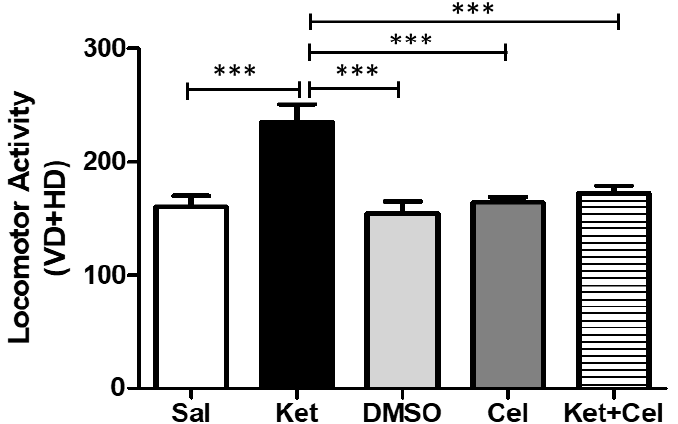
Figure 2. Celastrol administration in postnatal life prevented ketamine-induced increased in locomotor activity in later adulthood. Locomotor activity (VD = vertical displacements; HD = horizontal displacements) in adult mice receiving saline (Sal, n = 7) or ketamine (Ket, n = 13) or a 50% DMSO in PBS (DMSO, n = 7) or celastrol (Cel, n = 8) or ketamine + celastrol (Ket + Cel, n = 14) at